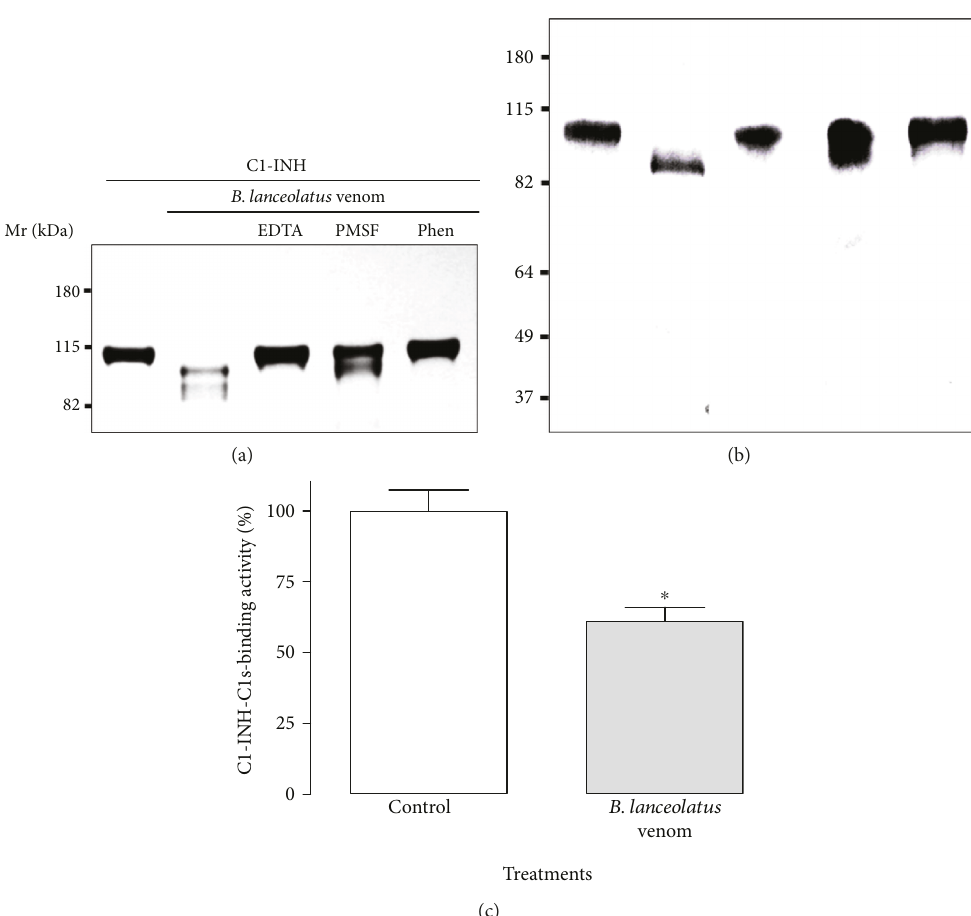
Figure 4: Cleavage of puri fi ed Complement regulator C1-INH by B. lanceolatus venom and its residual C1s-complexing activity. C1-INH (2 μ g) samples were incubated with B. lanceolatus venom (2 μ g) for 30 min at 37 ° C and the cleavage was visualized by SDS-PAGE electrophoresis, followed by silver staining (a), or by Western blot using anti-C1-INH antibodies (b). The residual C1s-complexing activity of the C1-INH fragments was assessed by functional ELISA (c). The results represent the mean of two independent experiments, carried out in triplicates. Data are represented as mean ± SD. ∗ p < 0 05 between two